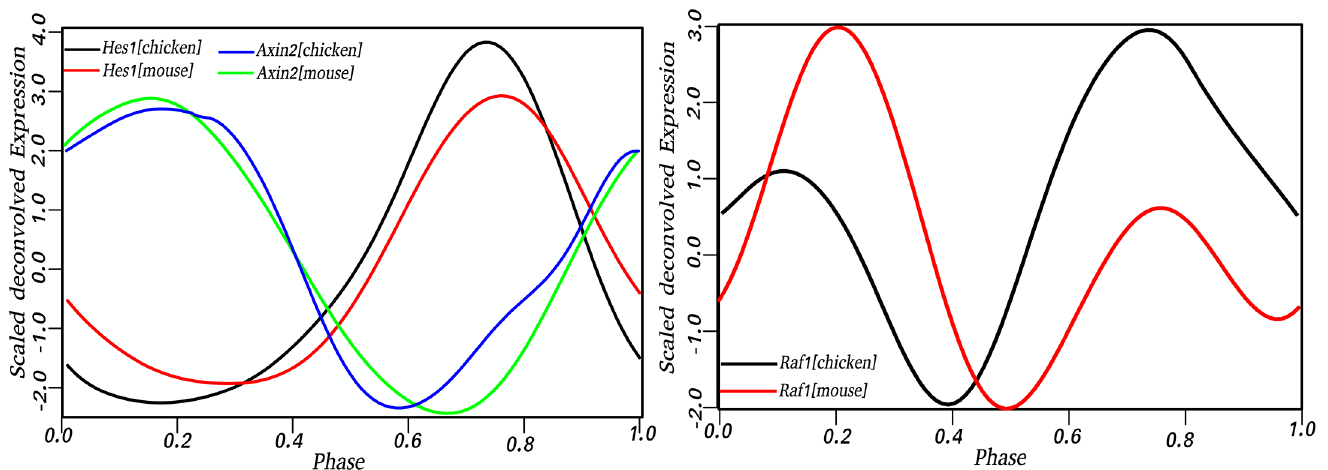
Fig 1. Phase conservation between mouse and chicken. Axin2 , Wnt-related cyclic gene oscillates opposite phase to Hes1 (Notch-related gene) suggesting a phase conservation between mouse and chicken. Raf1 , an Fgf-related gene previously shown to have two peaks of expression during mouse somitogenesis showed the same pattern of expression in chicken. Phase of gene expression varies from 0 to 1 and corresponds to 120 and 90 minutes periodicity for mouse and chicken